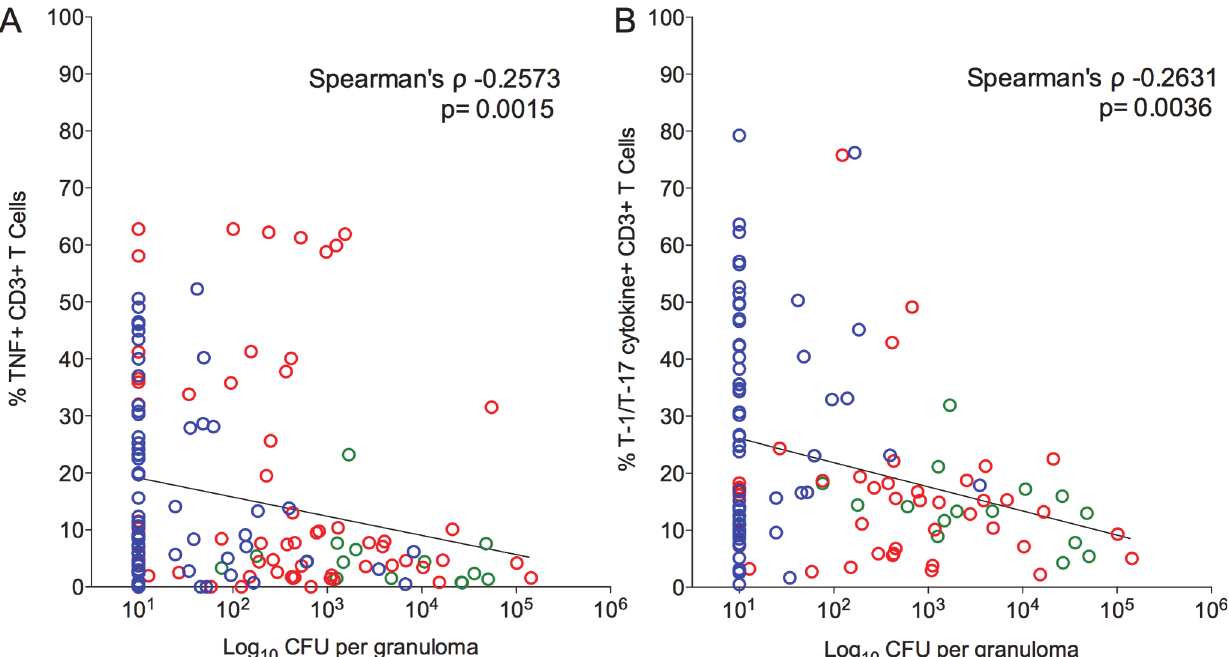
Figure 6. Correlation of pro-inflammatory T cell cytokine response to the bacterial burden (CFU per granuloma) in each of the individual granulomas. Significant inverse correlation was observed between frequencies of TNF ( A ) and T-1/T-17 ( B ) producing T cells and bacterial burden. CFU per granuloma value of zero were transformed to “ 1 ” and included in this analysis. Each symbol represents a granuloma. Line indicates the slope. The clinical status of an animal is represented by the color of the granuloma. Animals with active disease are in red, latent infection in blue and those with * 11 weeks of infection are in green.